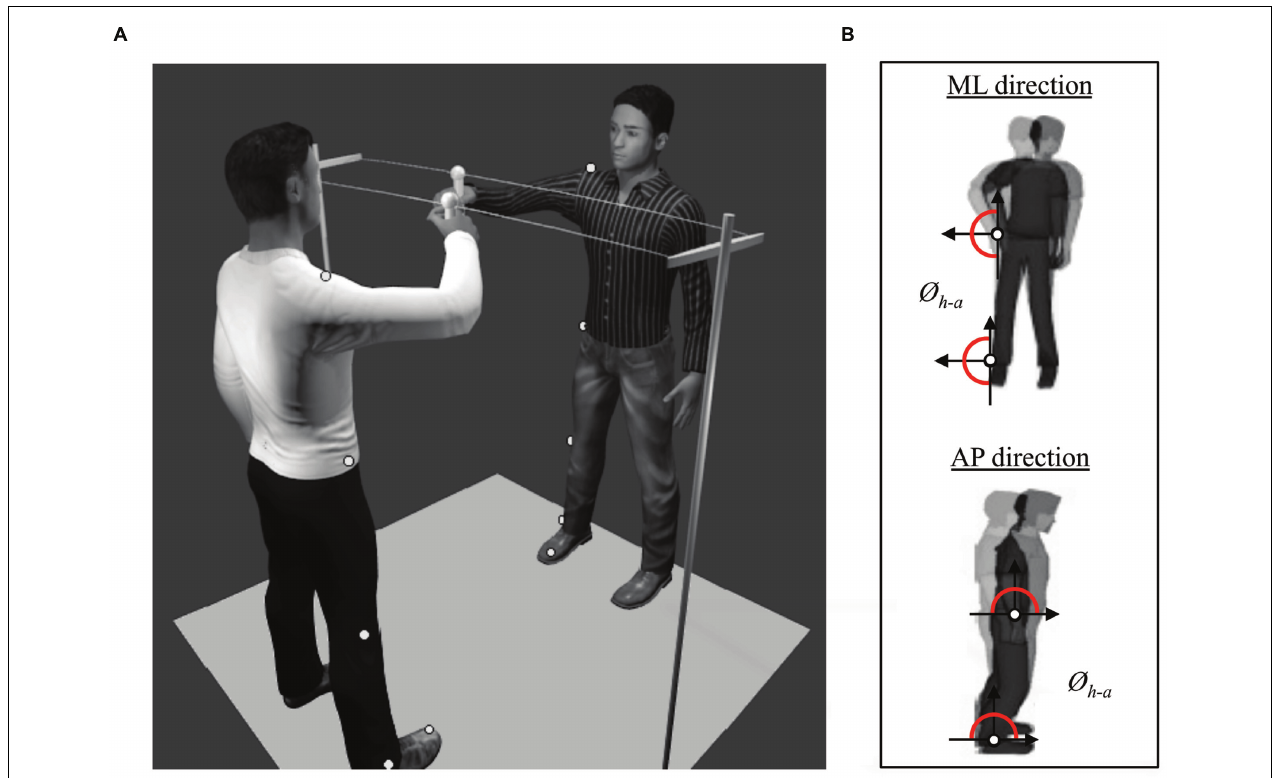
FIGURE 1 | (A) Set-up of the protocol showing two participants engaged in a one-dimensional motor improvisation task (a.k.a. mirror game) consisting in sliding a hand-held handle along a string (Duo situation). Five passive markers were pasted on each participant to record the angular displacements of relevant joints. The “MakeHuman” model is part of the open source modeling tool “MakeHuman” (www.makehuman.org). Blender 2.72b was used to create the environmetal set-up. (B) Illustration of the computed relative phase (Ø h - a ) between the angular position of hip and ankle in ML and AP directions (respectively top and